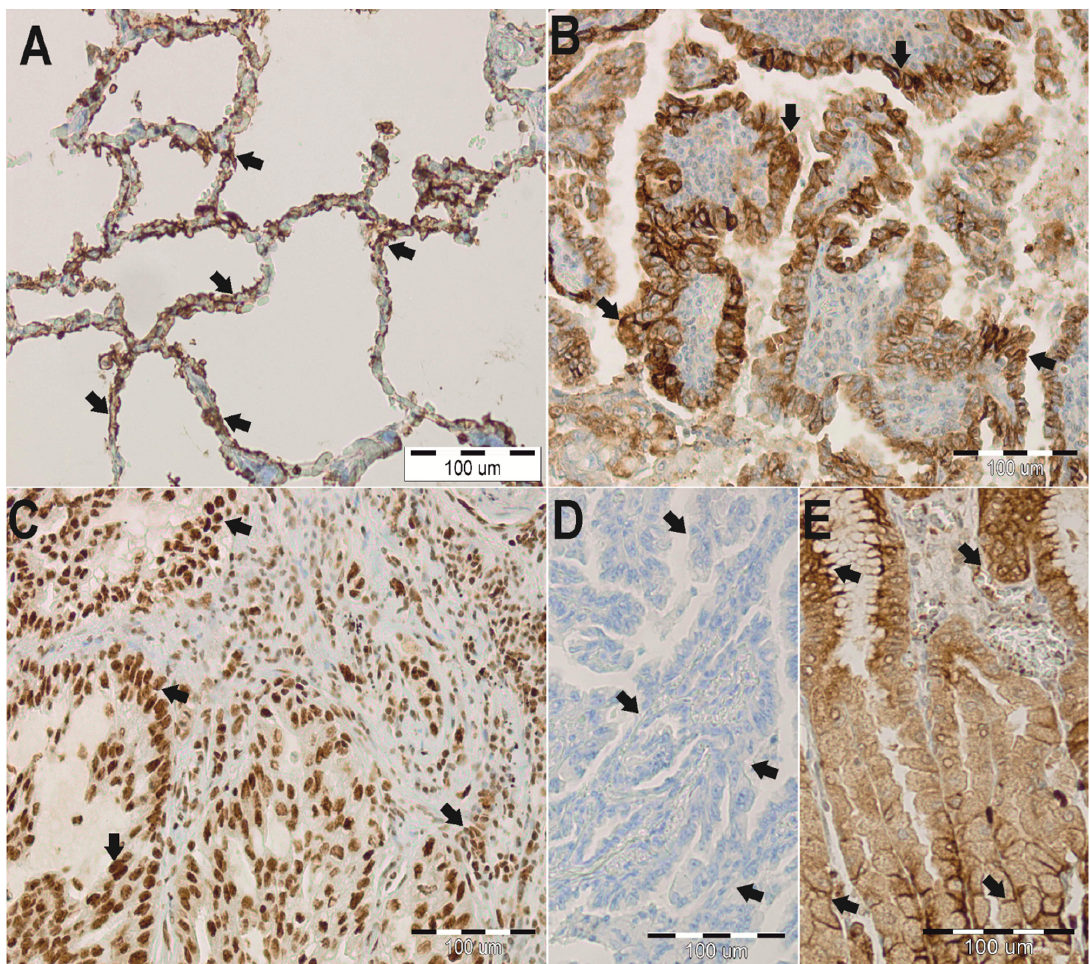
Figure 2. Immunohistochemistry (IHC) staining of aquaporin 4 (AQP4) in paraffin-embedded sections of the lung adenocarcinoma (ADC) from humans. Anti-AQP4 antibody labels in non-neoplastic lung tissues. Arrows indicate the localization of the type I pneumocytes and macrophages ( A ). Anti-AQP4 antibody labels in the cancer lung tissues. Arrows indicate the localization of AQP4 in the cytoplasmic membrane in the cancer cells ( B ) and aberrant nuclear reaction in cancer cells ( C ). No staining was observed when isotype-specific immunoglobulins from non-immunized rabbits were used instead of the primary antibody (negative control) ( D ). Immunoperoxidase labeling of AQP4 from the human stomach (positive control) ( E ). The labeling is seen in the basolateral plasma membrane of the surface epithelial cells and parietal cells of gastric gland cells. The blue color represents a positive staining for the hematoxylin counterstain, and the brown color represents positive AQP4